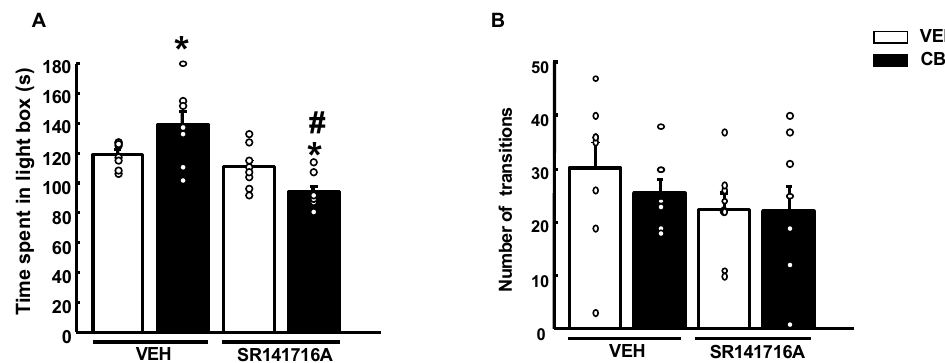
Figure 6. Effects of a single administration of cannabidiol (CBD) (20 mg/kg, i.p.) in mice pre-treated with the cannabinoid receptor 1 (CB1r)-antagonist SR141716A (2 mg/kg, i.p.) on the light-dark box test. The behavioral evaluation was developed 2 h after SR141716A (or vehicle) and 1 h and 30 min after the administration of CBD (or vehicle (VEH)). Columns represent the means and vertical lines ± SEM of the time in the lightbox (s) ( A ) and the number of transitions ( B ). * Values from CBD-treated mice that were different ( p < 0.05) from vehicle (VEH)-treated mice, and # values from SR141716A + CBD-treated mice that were different from VEH + CBD and SR141716A + VEH-treated animals (two-way ANOVA followed by Student–Newman–Keuls test, p < 0.05).